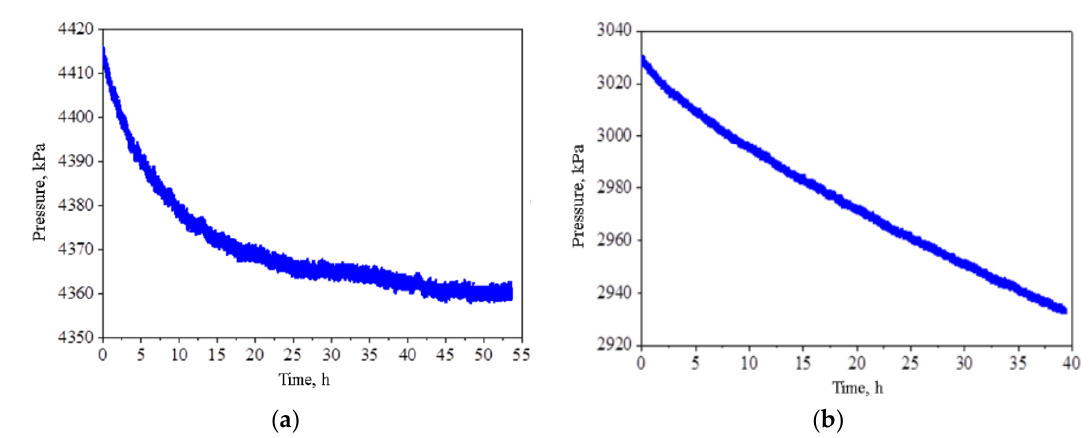
Figure 3. The pressure decay curve during shale imbibition. ( a ) The pressure decay during imbibition of N-8, and ( b ) the pressure decay during imbibition of N-67.